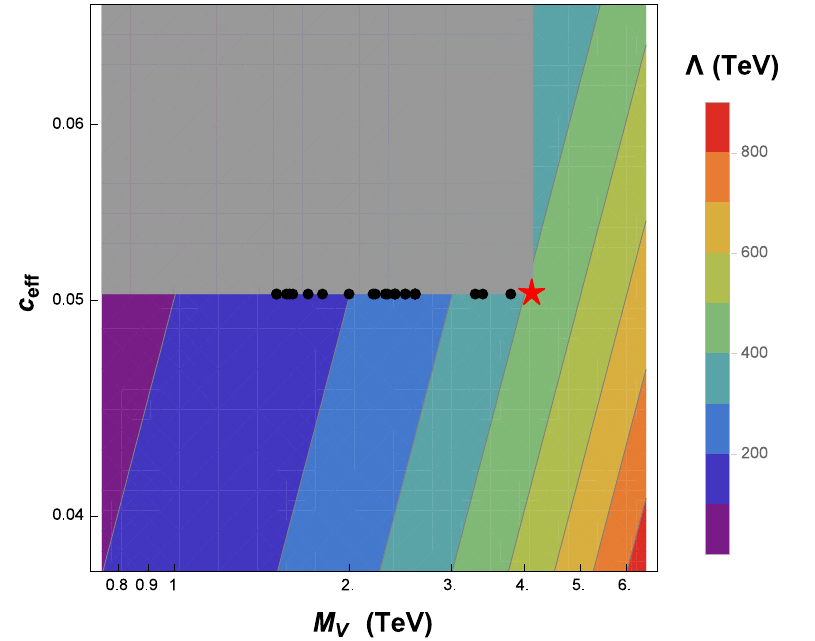
Figure 2 . Exclusion regions based on diboson production experimental analyses [73{87] (shaded gray region). The black dots represent the values ( M bound B g studies, representing the red star the most stringent constraint M bound V =3 c 2 = (4 M 2 ) = 2 (cid:25) (cid:3) (cid:0) 2 , with the value for each point given by the color legend on the right-hand V e(cid:11) side. More details are given in the